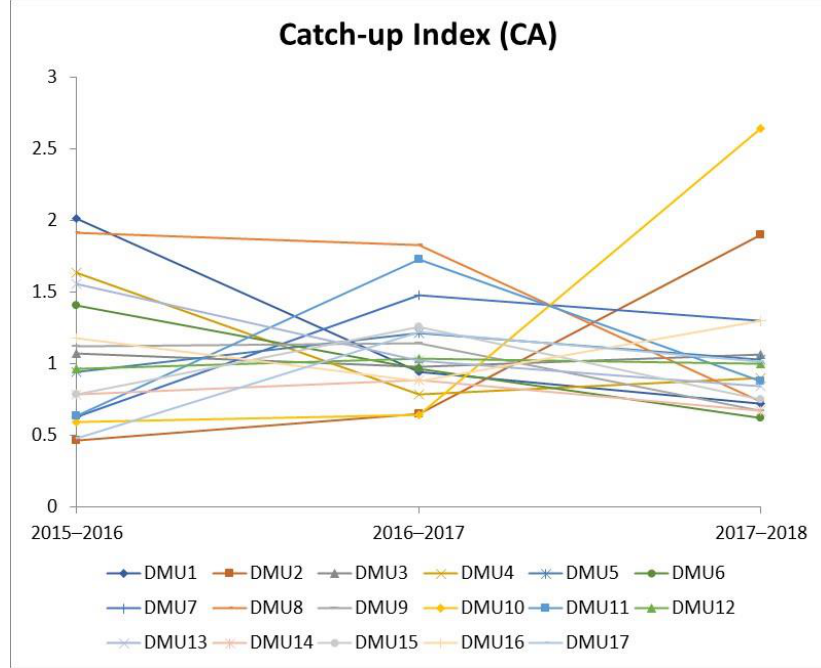
Figure 3. Technical efficiency change (Source: calculated by the researcher).